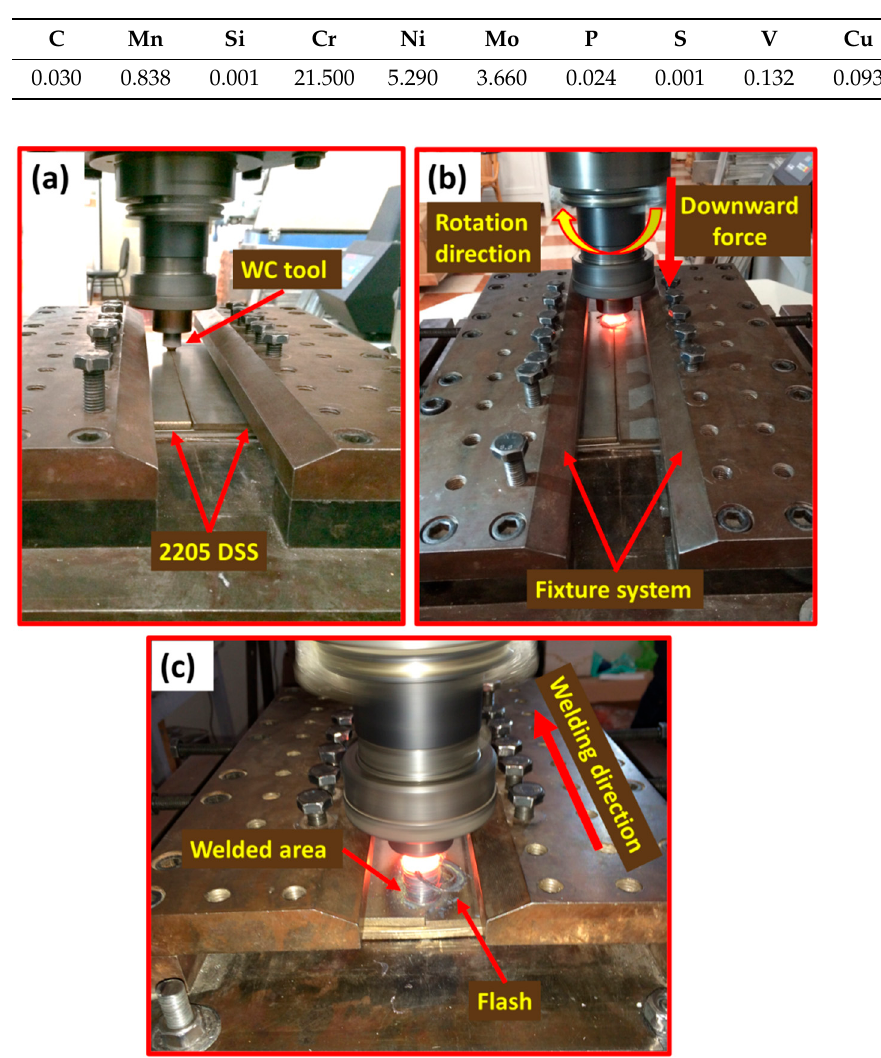
Table 1. The 2205 DSS Chemical Composition (in wt.%).